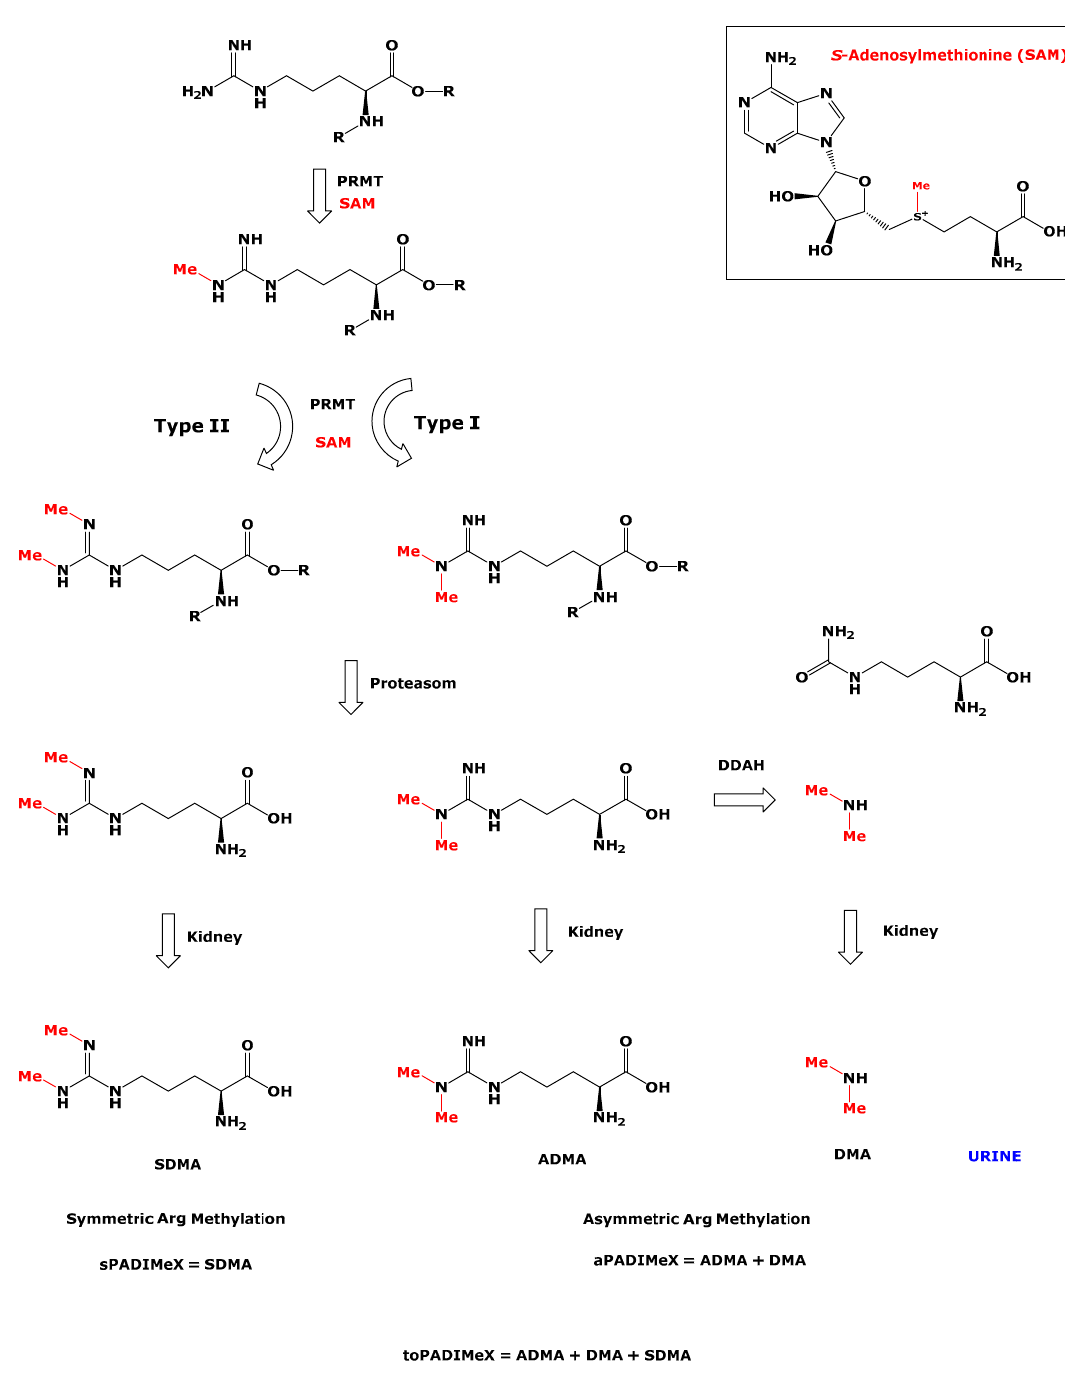
Figure 1. Simplified schematic of the asymmetric and symmetric methylation (ADMA and SDMA respectively) of arginine residues in proteins, their proteolysis to free ADMA and SDMA, metabolism of ADMA by dimethylarginine dimethylaminohydrolase (DDAH) to dimethylamine (DMA), and their excretion in the urine. Proposal of the protein arginine dimethylation index (PADiMeX).